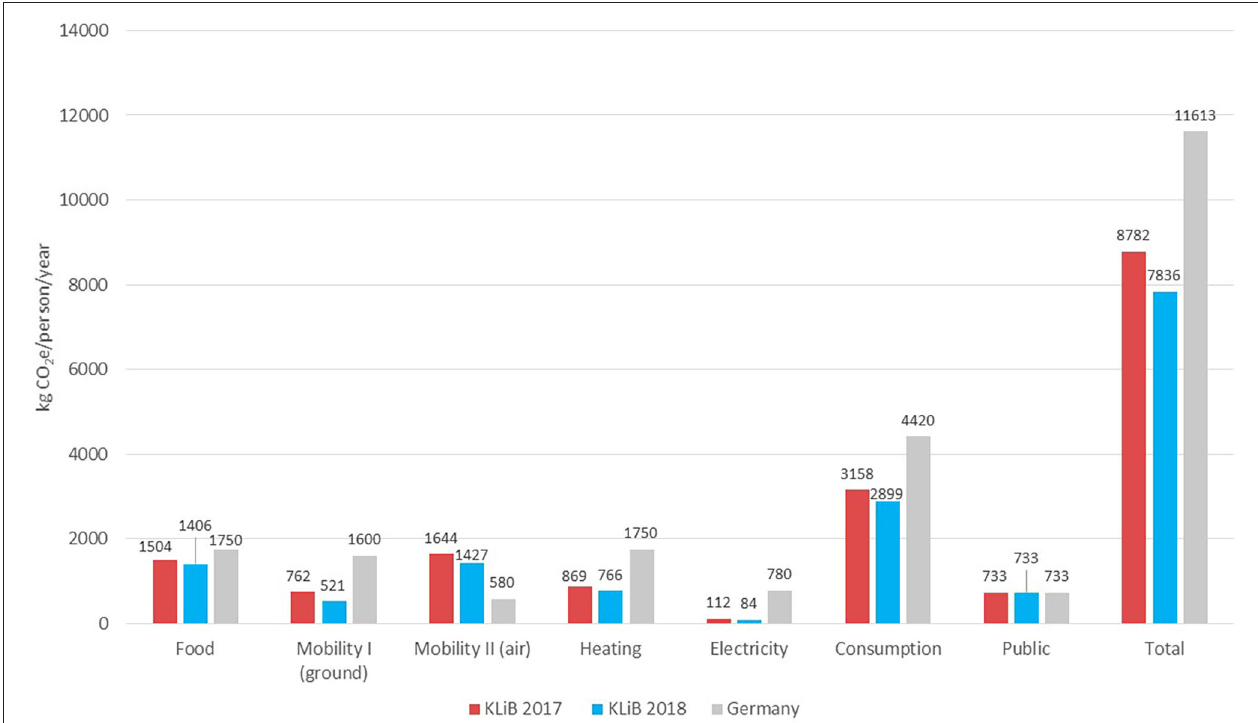
FIGURE 1 | Baseline (2017) (red) and real-lab sectoral performance (2018) results of KliB households (blue) in comparison with German average (gray) in total kg CO 2 per person and year. Source: Own